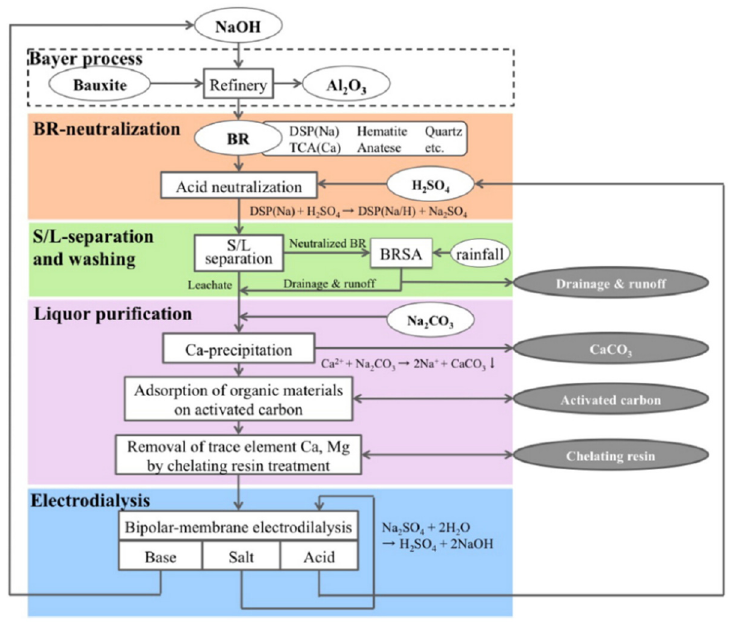
Figure 4. Process of in situ remediation of bauxite residue by sulfuric acid neutralization [34].